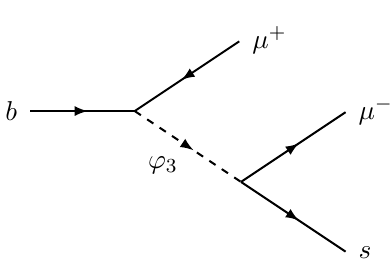
Figure 2. Dominant model contribution to the neutral current b ! s(cid:22)(cid:22)